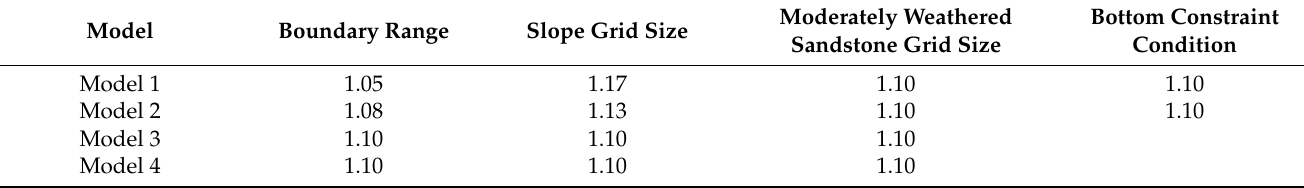
Table 6. Slope stability factors with different model